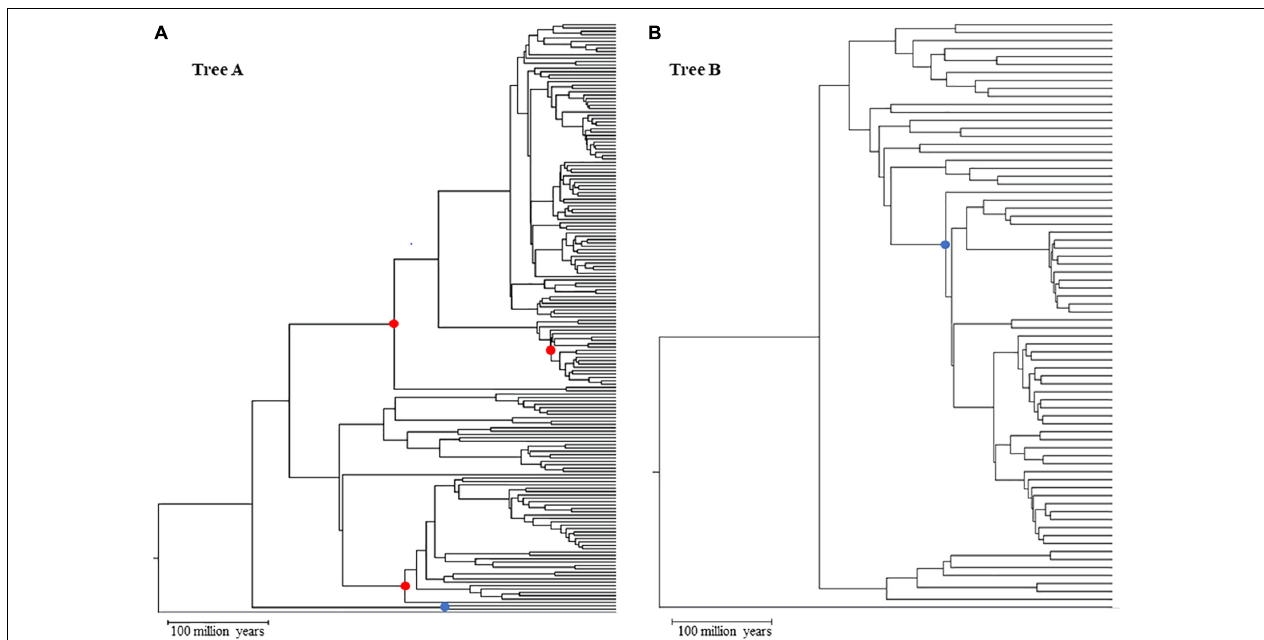
FIGURE 1 | Topologies used in simulated analyses for Tree A (A) and Tree B (B) red dots primary calibration nodes; blue dot: overlapping node between trees A and B used as secondary calibration in tree (B) . Gray branch